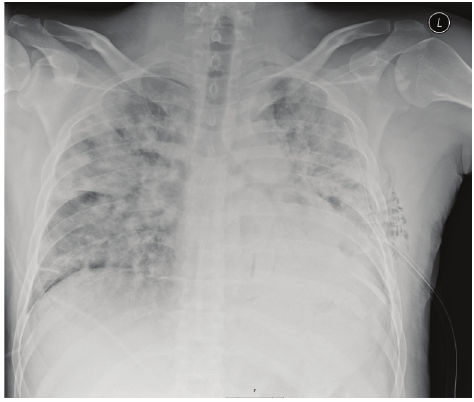
Figure 2. Chest radiograph one hour after drainage of the left hemopneumothorax showing bilateral pulmonary edema.